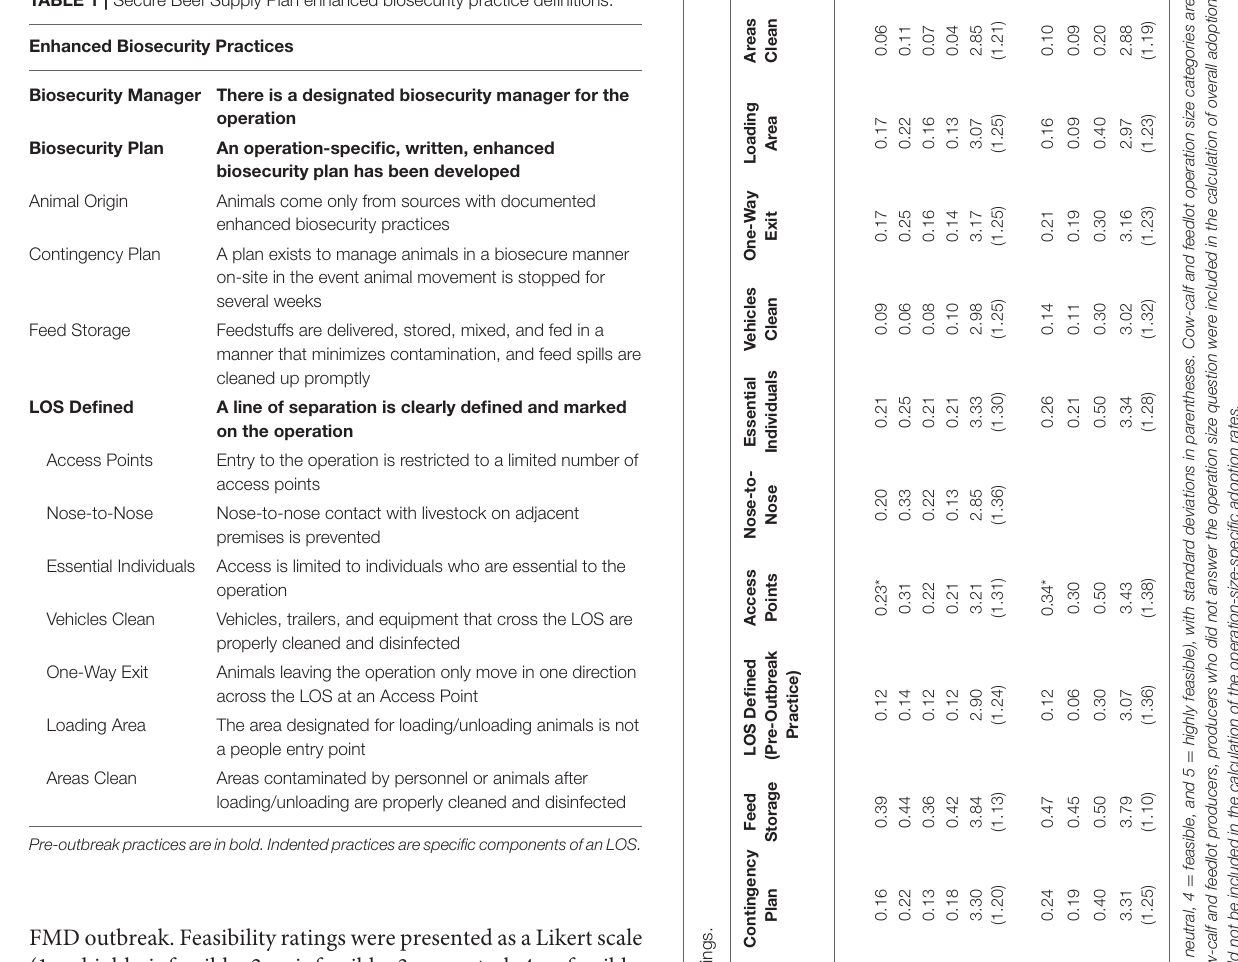
TABLE 1 | Secure Beef Supply Plan enhanced biosecurity practice